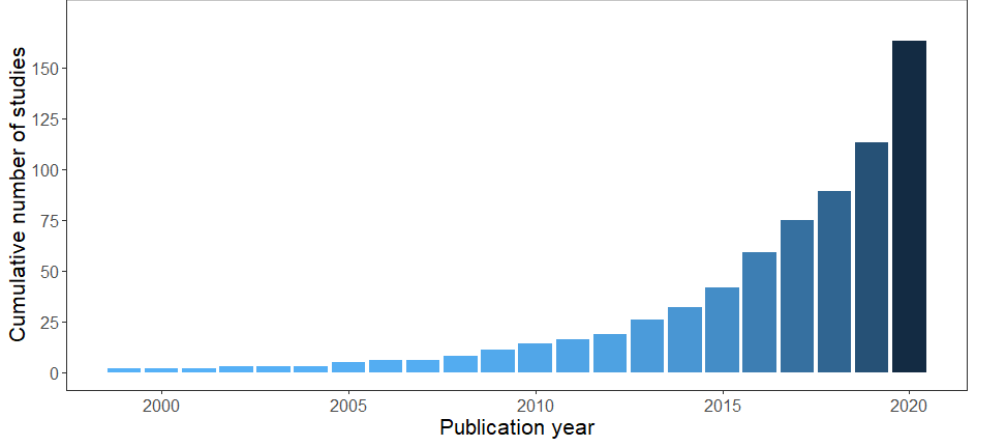
Figure 1. Exponential increase in time of published studies used in our overview (the bar left of 2000 refers to all studies before the year 2000). In total 163 unique studies (peer-reviewed publications) were used: 154 meta-analysis studies and 9 reviews.